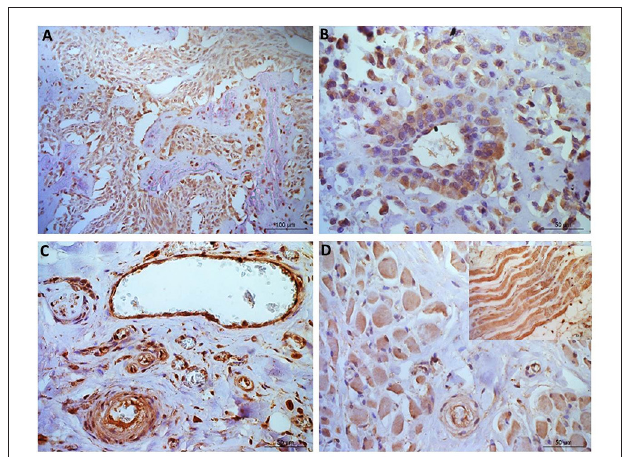
FIGURE 4 | Osteosarcoma immunohistochemical staining for NRF2. (A, B) Immunopositive staining in blood vessels, primarily nuclear, in all 10 samples within the tunica intima and in 40% of samples tunica media staining was observed. (C) Negative staining in the osteoid (tumor free area). [ (D) + inset] Muscle tissue showing positive NRF2 staining. Scale bars represent (A) 100 µ m, (B–D) 50 µ